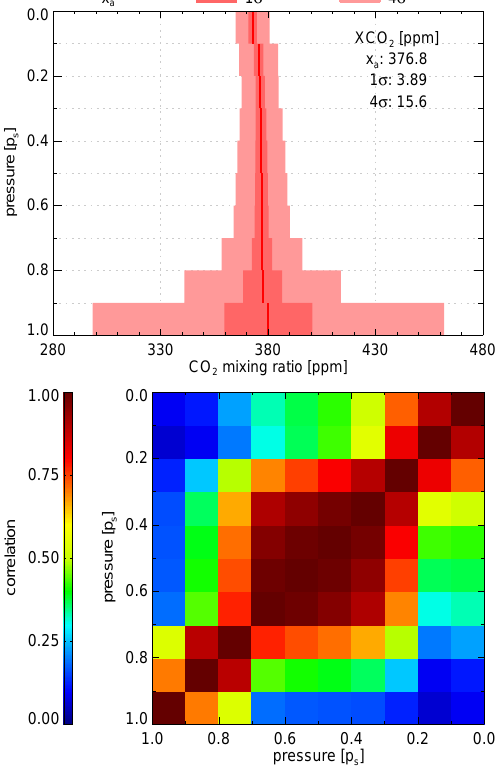
vector and are set to constant values.